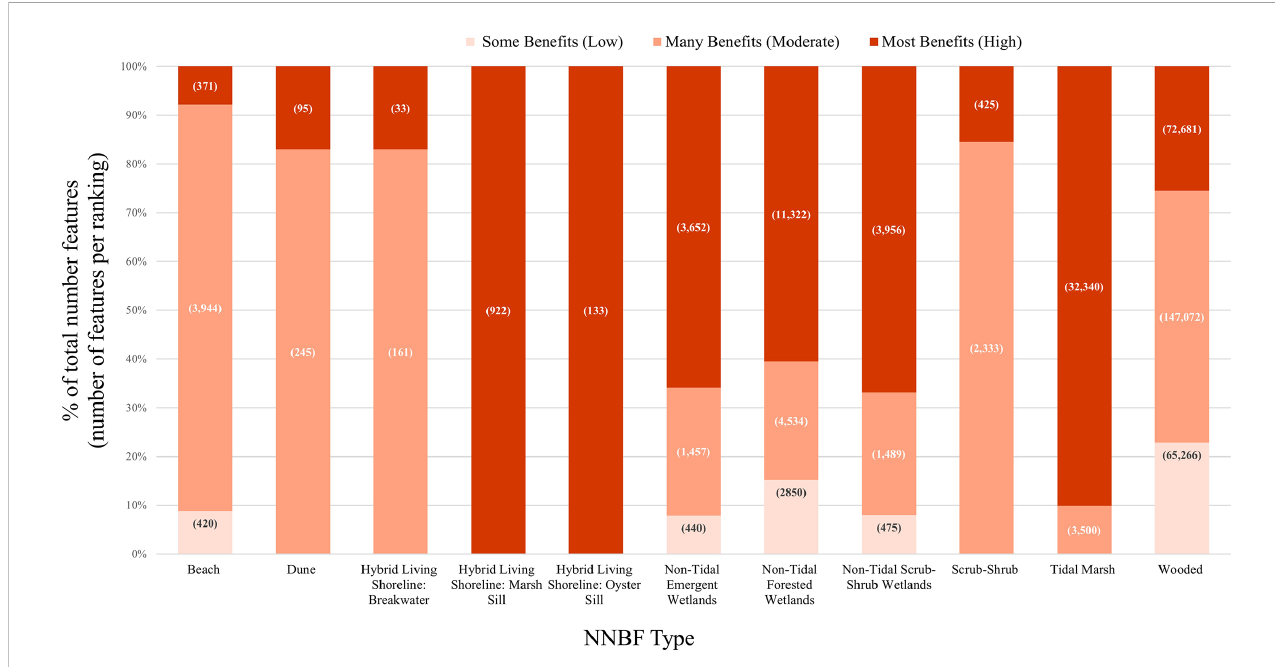
FIGURE 6 NNBF features and their CBI ranking, by percent of total number of